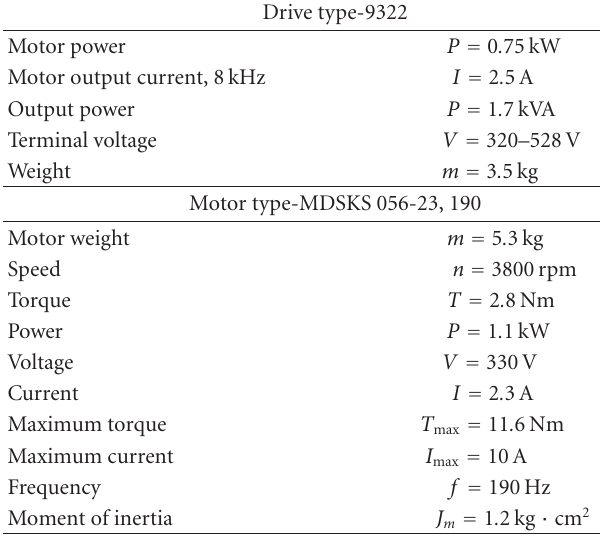
Table 1: AC servomotor-driver data